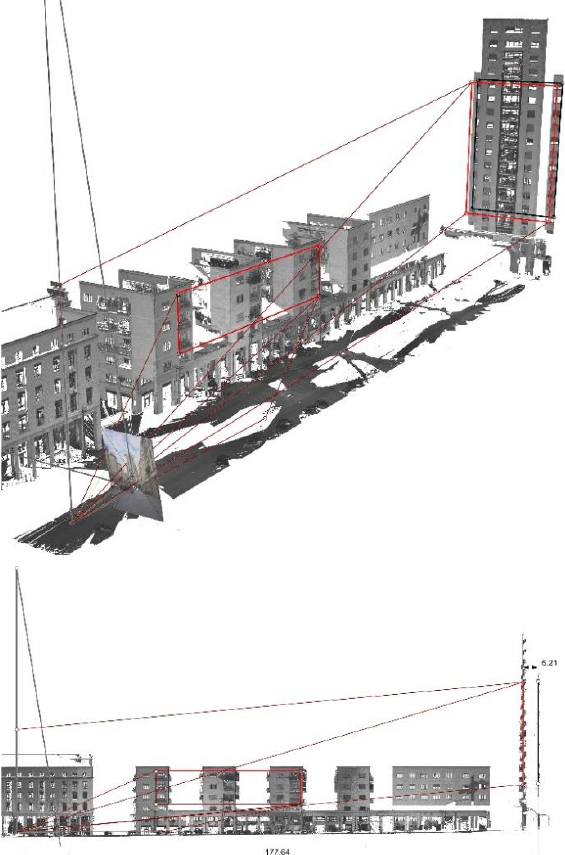
Figure 14: Image taken with a standard mirrorless camera mounting a 35mm lens.